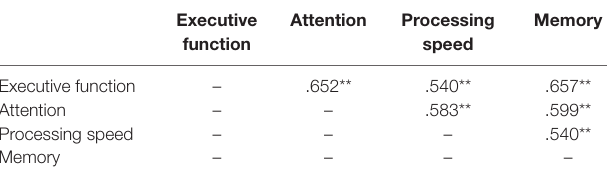
TaBlE 3 | Correlations among the four cognitive domains in the whole sample